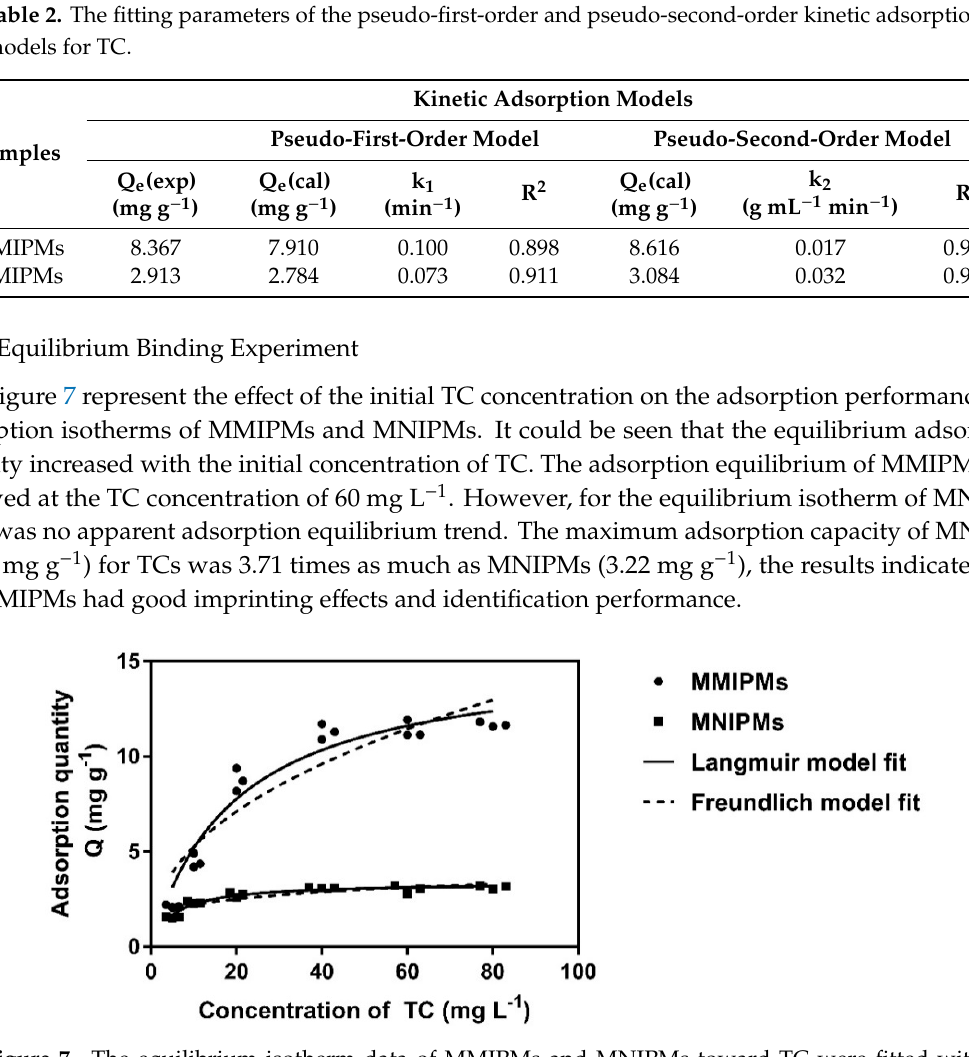
Table 3. The fitting parameters of Langmuir and Freundlich isotherm adsorption models for TC.